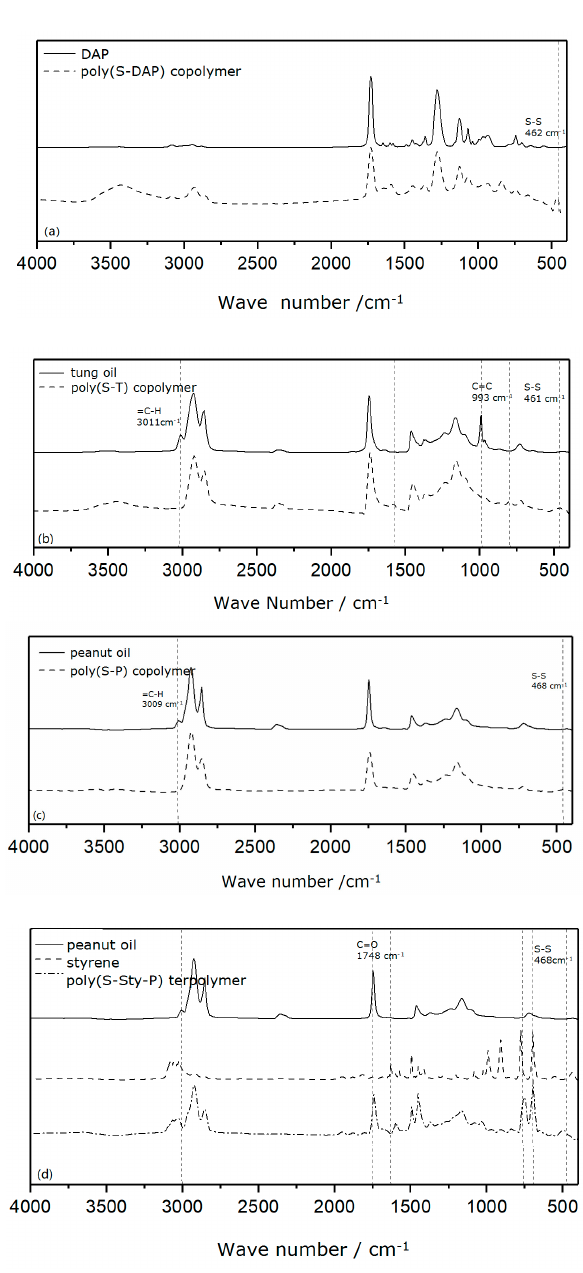
Figure 5. ( a ) The infrared spectrum of poly(S-DAP) copolymer and contrast DAP; ( b ) the infrared spectrum of poly(S-T) copolymer and contrast tung oil; ( c ) the infrared spectrum of poly(S-P) copolymer and contrast peanut oil; ( d ) the infrared spectrum of poly(S-Sty-P) terpolymer and contrast peanut oil, styrene.